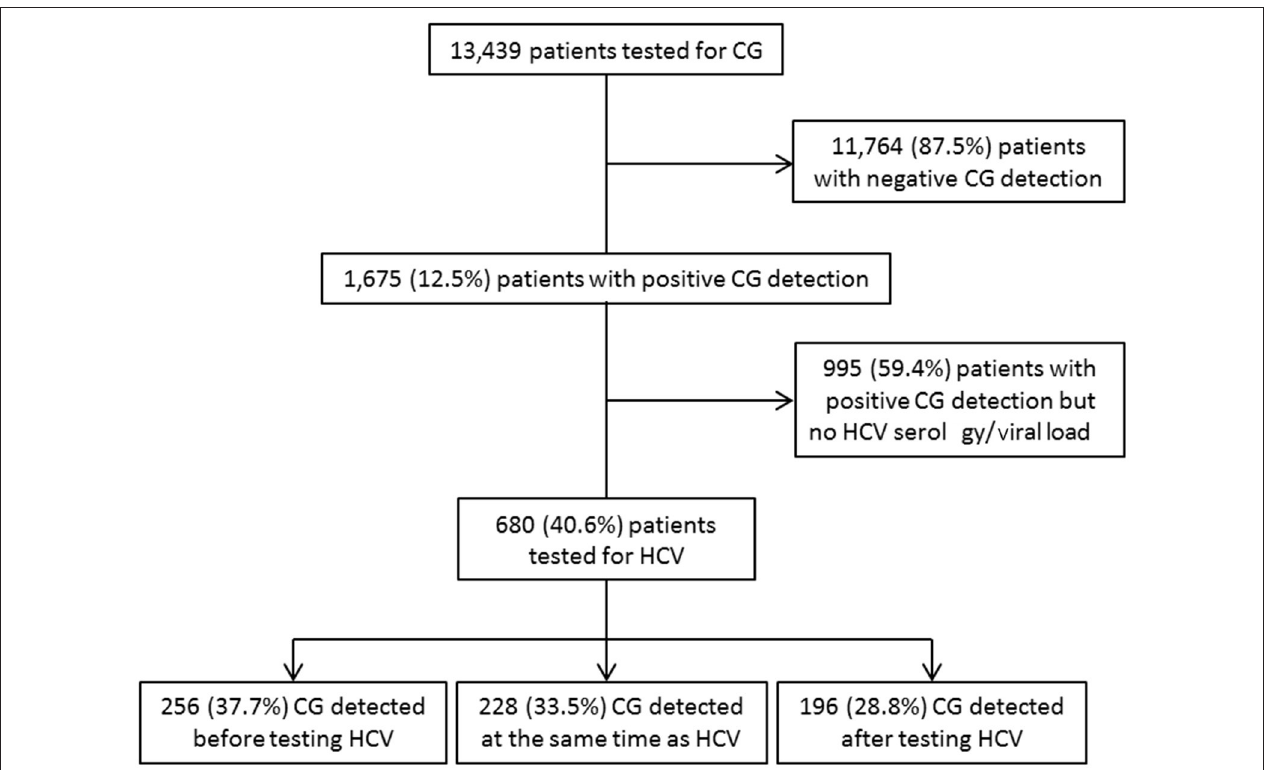
FIGURE 1 | Study flowchart of patient inclusion within the study period (2010–2016) and relation with HCV status